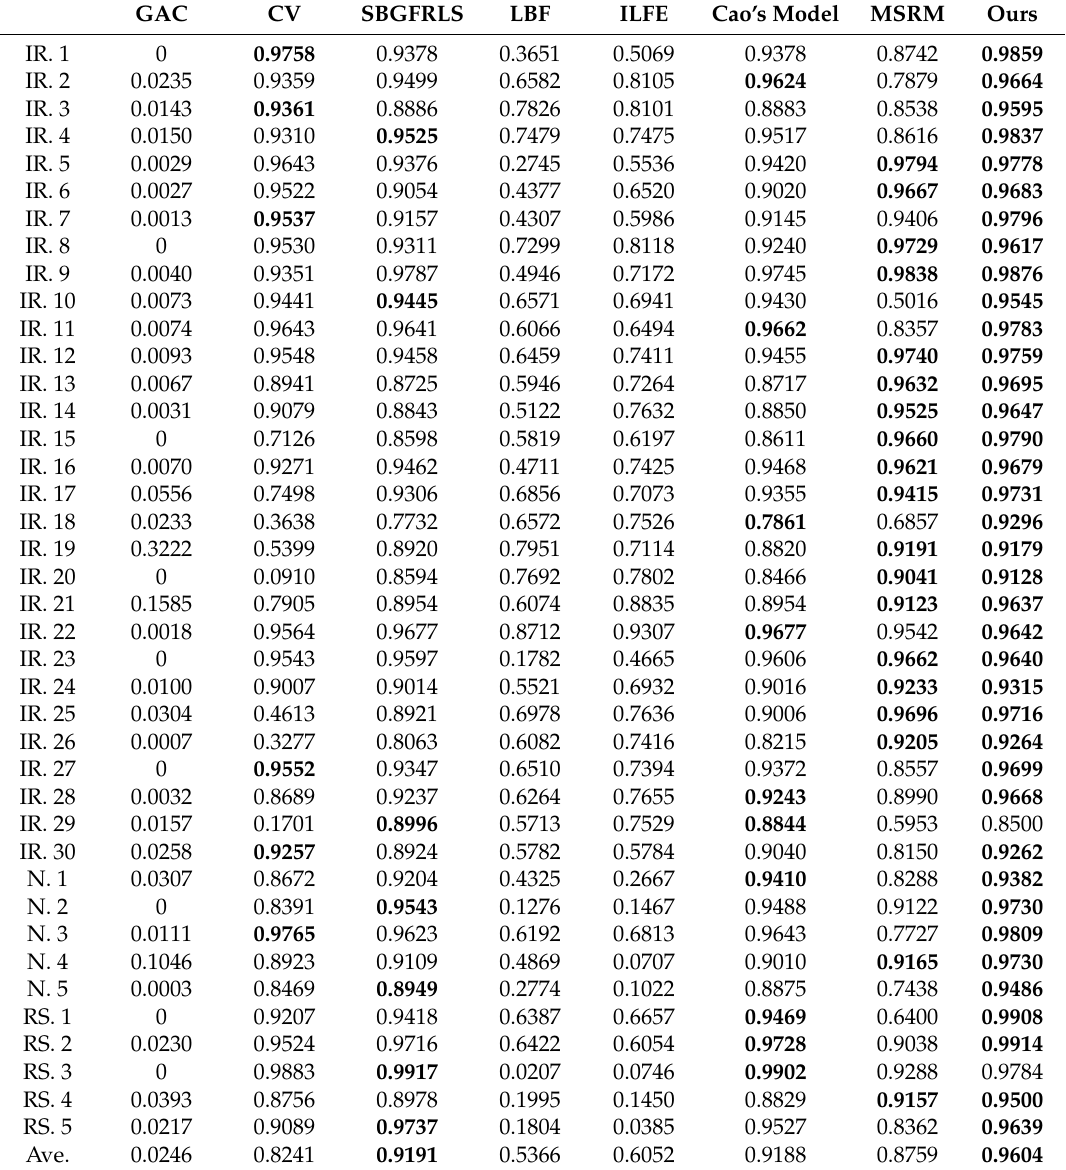
Table 2. Statistic for F values, and bold values indicate the top two